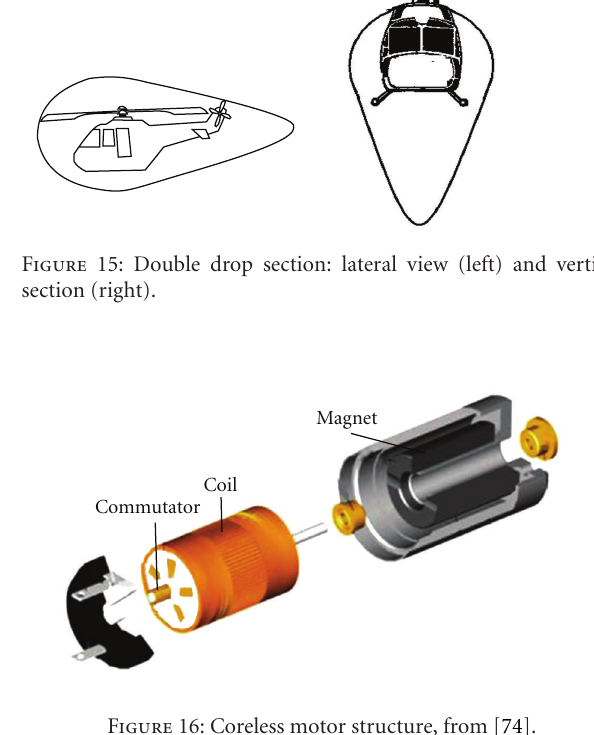
Table 3: Flying principle comparison focused on ability to miniaturization [14] (1: bad, 2: medium, 3: good).